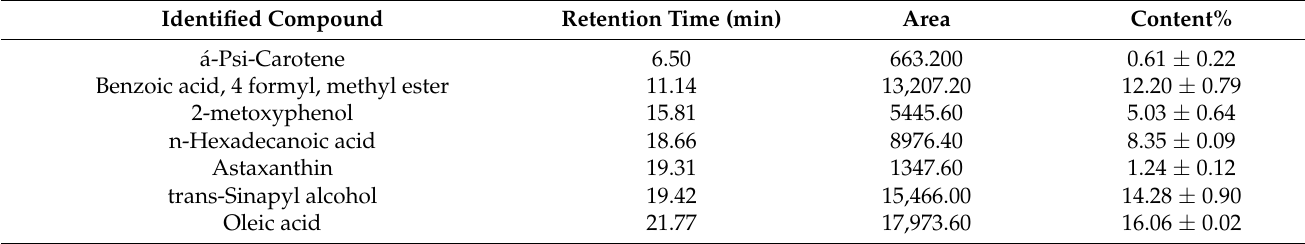
Table 6. The tentative identification of the main compounds in S. vulgaris bark extract by GC-MS analysis.